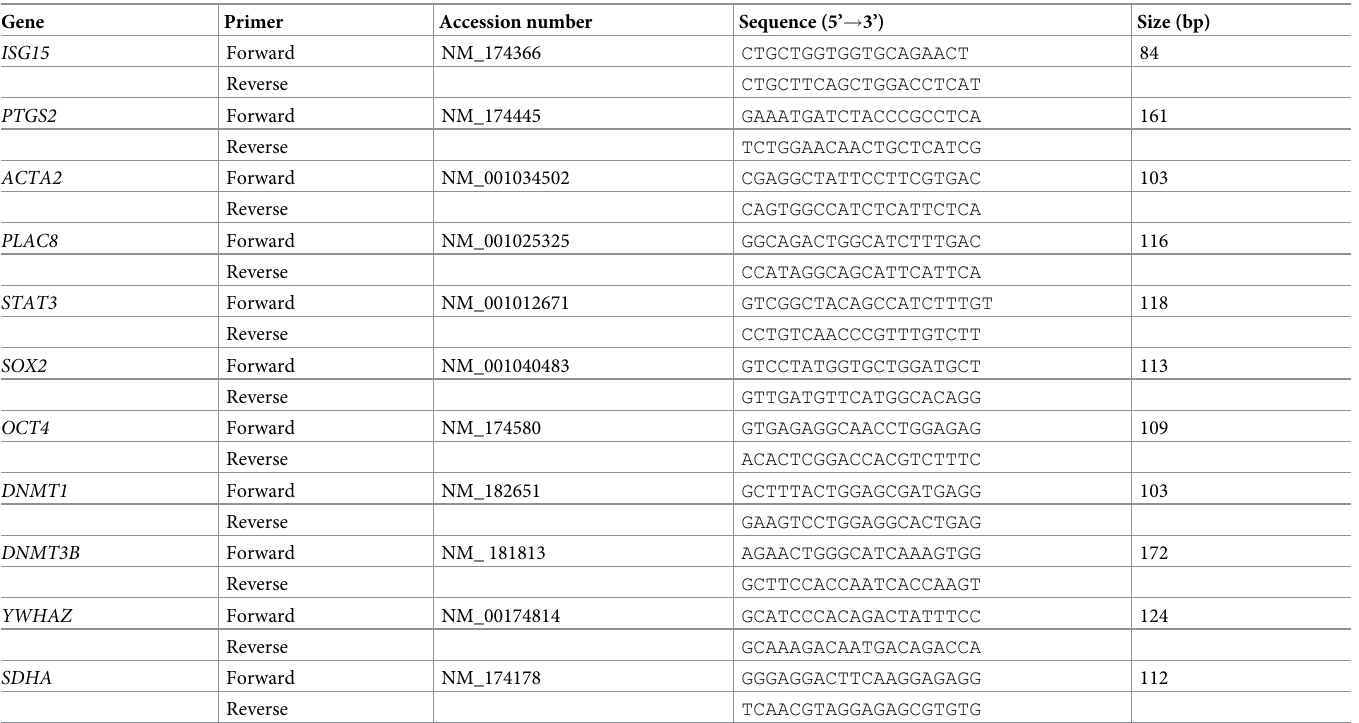
Table 1. Primers used for qRT-PCR